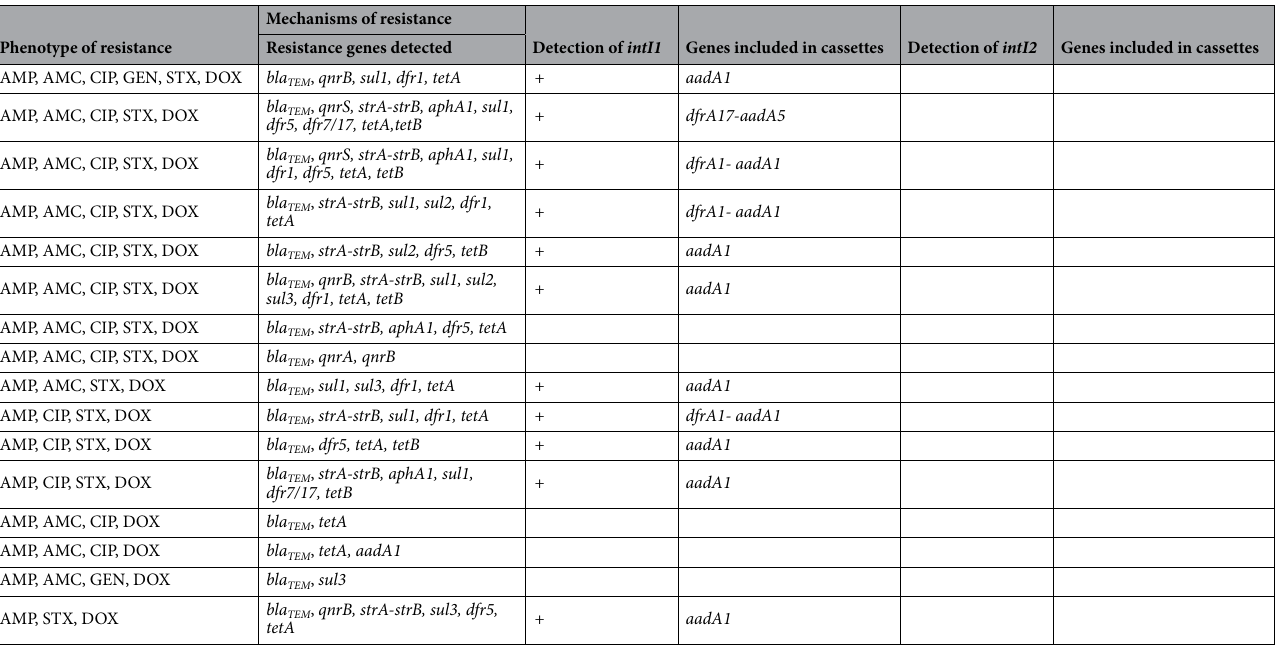
Table 3. Phenotypes, antibiotic resistance and prevalence of class 1 and 2 integrons and their resistance gene cassettes in MDR E. coli isolates obtained from poultry litter. (Group